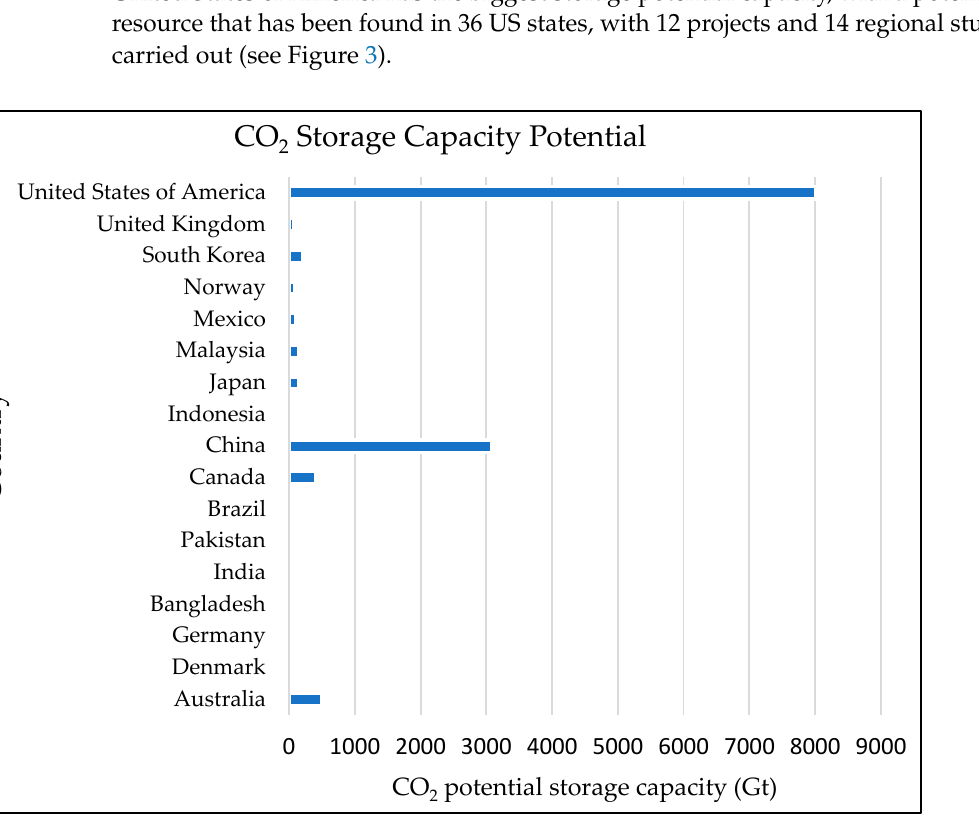
Figure 3. CO 2 potential storage capacity assessment across the countries (data source: CO 2 Storage Resource Catalogue Cycle 2 2021 [26]).